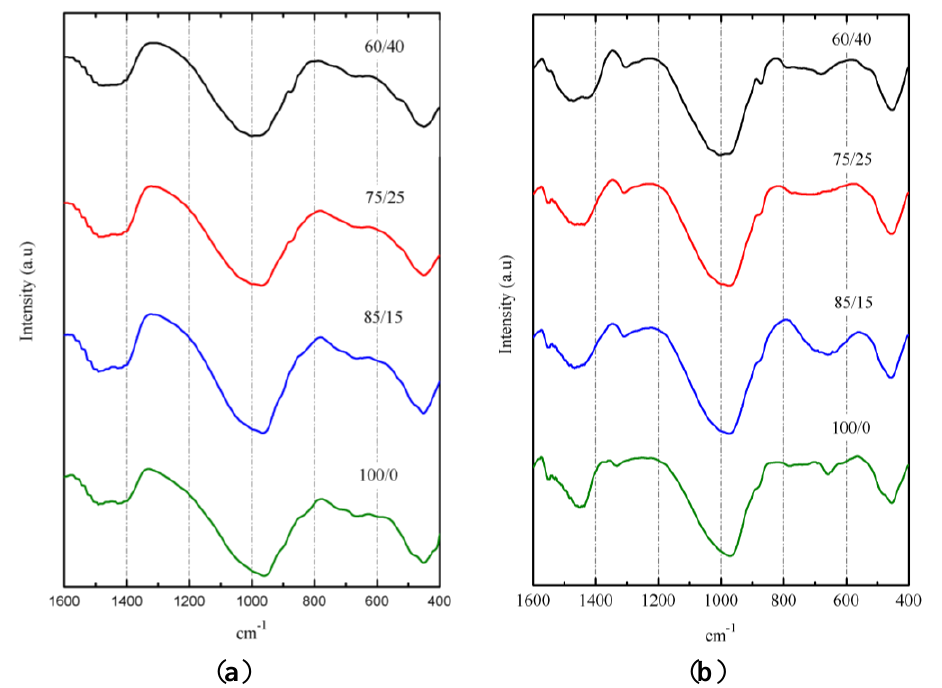
Figure 12. FTIR spectra for BFS/SCBA pastes: ( a ) cured at 65°C for 3 days; ( b ) cured at 20 °C for 270